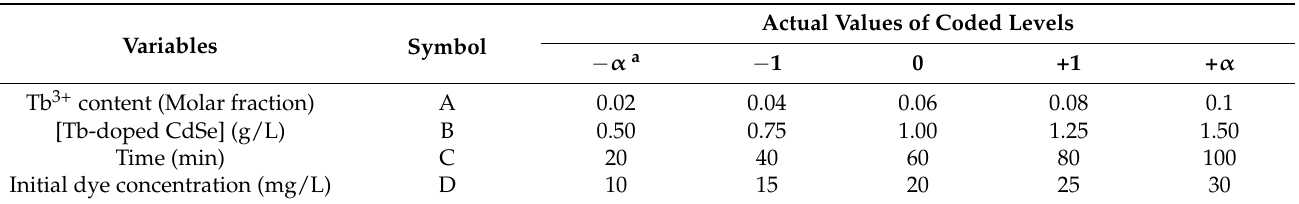
Table 2. The coded and actual values of independent variables utilized for experimental designs. ( a is the coded value for axial points).